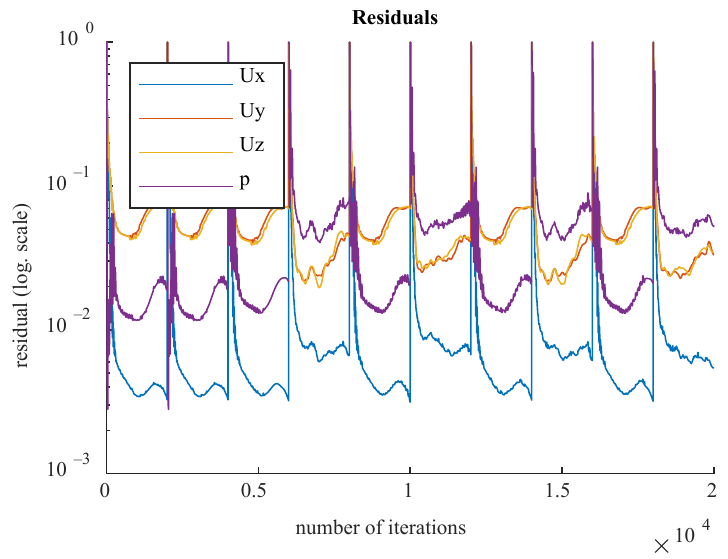
Figure 23. Residual history for steady-state simulation with shape of FDA nozzle model. The axial velocity results for the CFD steady-state and CFDPBA databases for